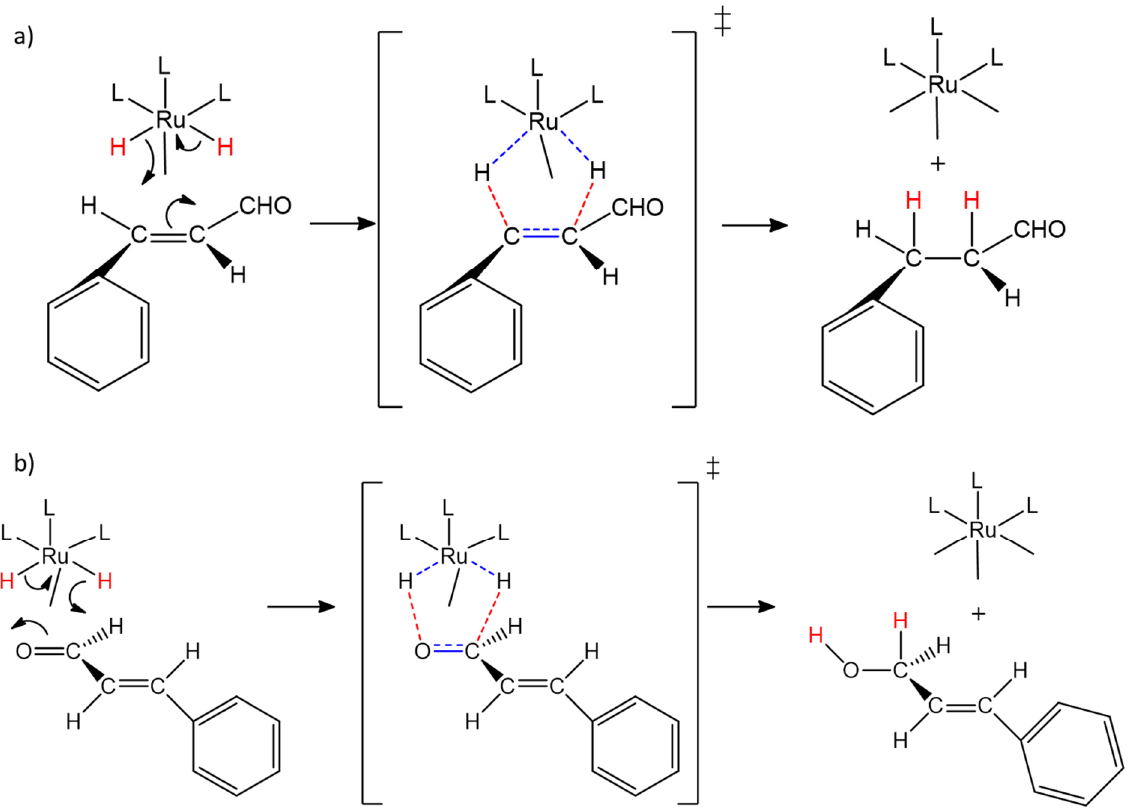
Figure 3. Concerted (4 σ + 2 Π ) hydrogenation mechanism of cinnamic aldehyde. ( a ) olefinic double bond and ( b ) carbonyl double bond. Dotted lines show the formation (red) and dissolution (blue) of the bonds in the concerted process.